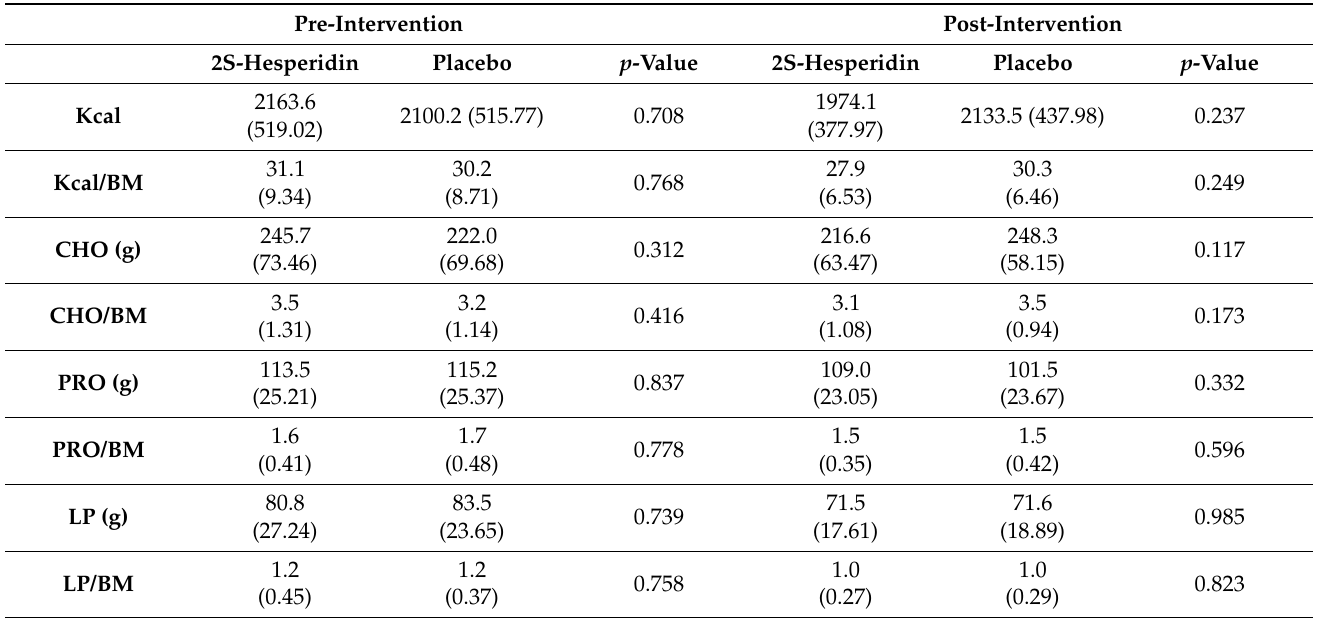
Figure 1. Study planning and rectangular test protocol. Table 2. Between-group comparisons of dietary intake of